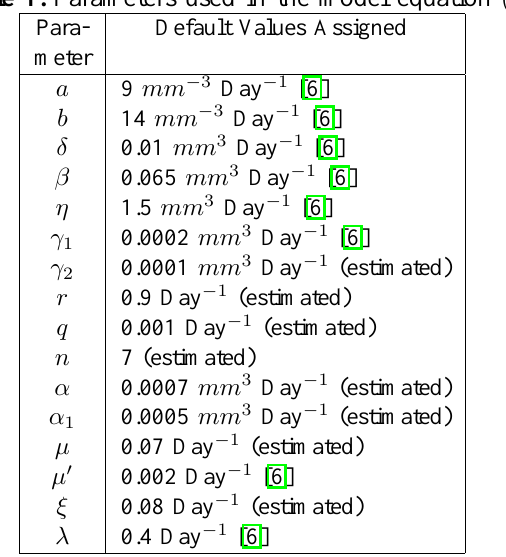
Table 1. Parameters used in the model equation (1)